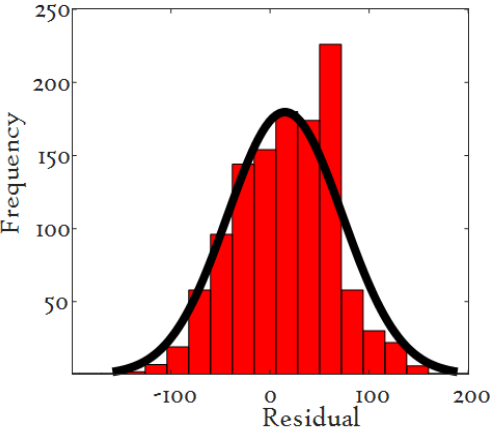
Figure 6. Histogram fitting of SVM-based power curve model.